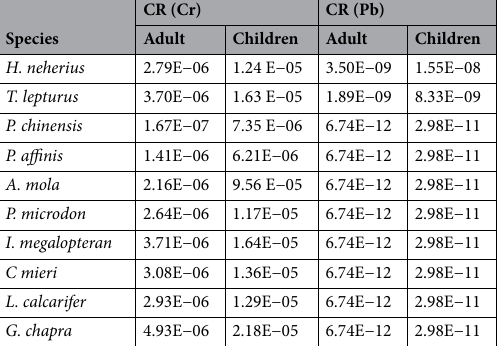
Table 8. Computed cancer risks (CR) from the two selected age groups, adults and